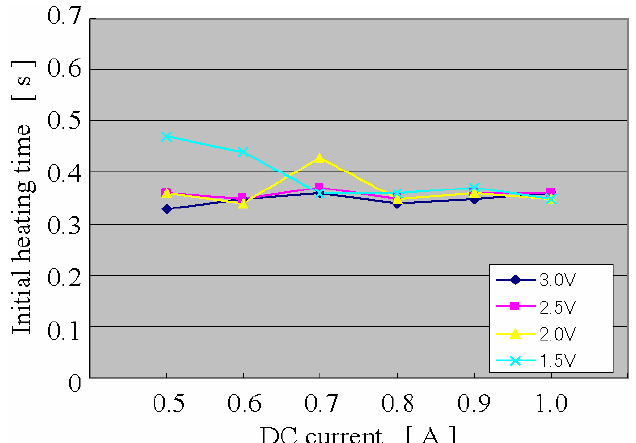
Figure 8. Initial heating times of SMA coil spring transducer for applied sets of DC voltage and current.